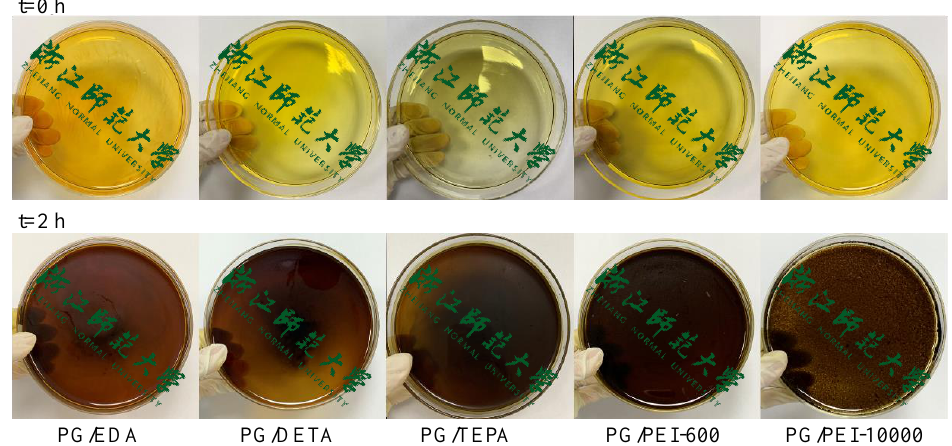
Figure 8. Optical images of PG/polyamine coating solutions before and after a 2 h co-deposition process (preparation conditions: PG/polyamine = 1:1, pH 8.0).